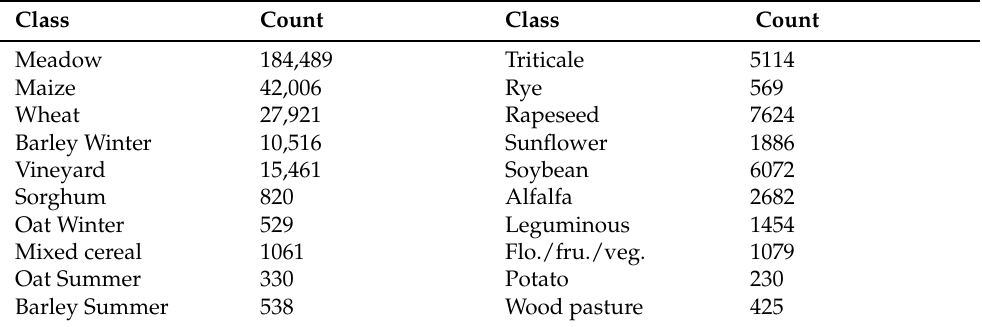
Table 1. Crop distribution. We indicate the number of parcels declarations in the LPIS for each class across all 103,602 parcels and all 3